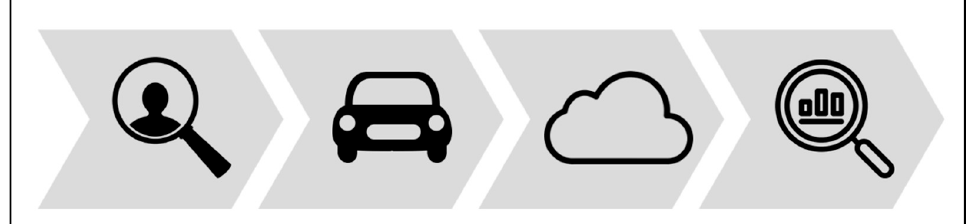
Figure 1. Methodological framework.